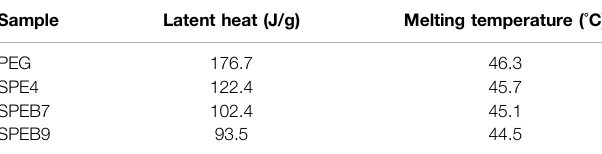
TABLE 2 | Latent heat and melting temperature of